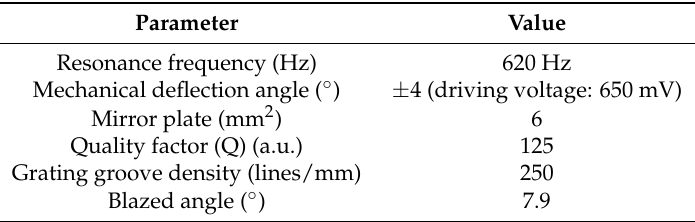
Figure 1. Schematic of the electromagnetic MEMS scanning mirror. ( a ) The integrated blazed grating (front) and driving and sensing coils (back); ( b ) scanning grating micro-mirror component. Table 1. Scanning tilted grating